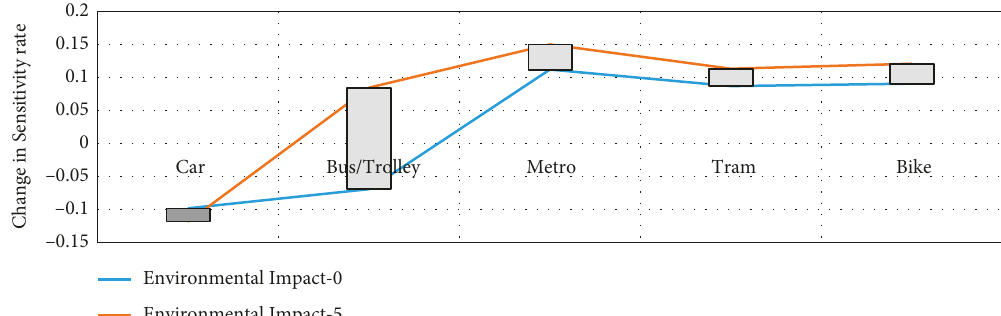
Figure 12: The comparison between the coefficients of the mode choice based on the changes in the environmental